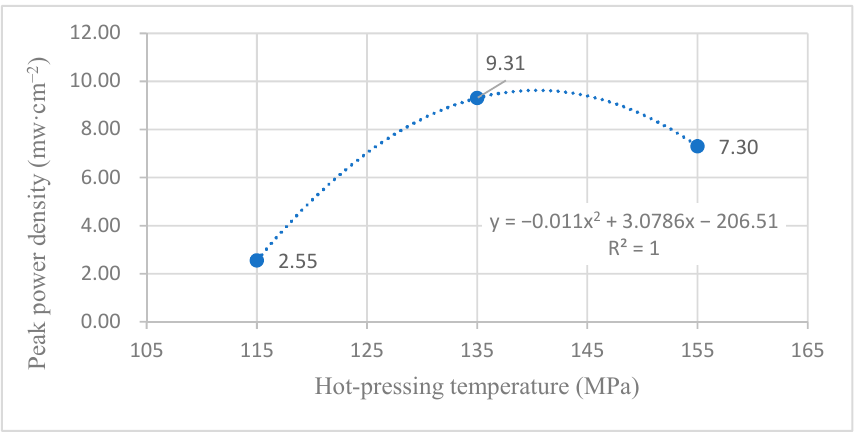
Figure 25. The fitting curve of the peak power density of MEA at a different hot-pressing temperature under 60 °C and air conditions.